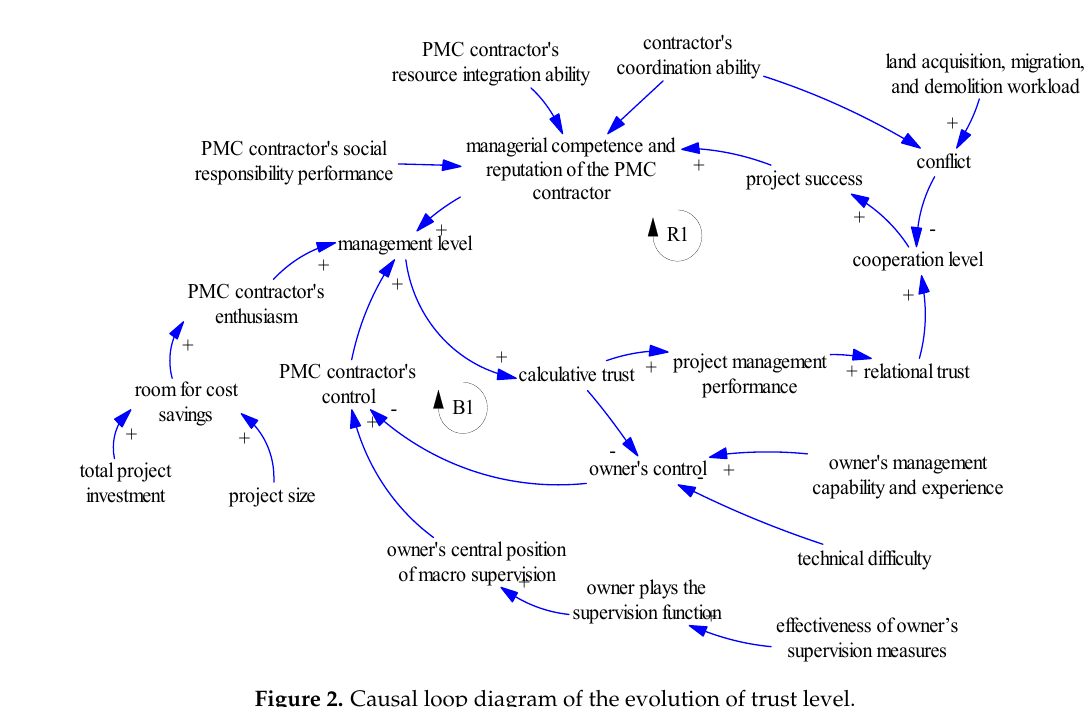
Figure 2. Causal loop diagram of the evolution of trust level.